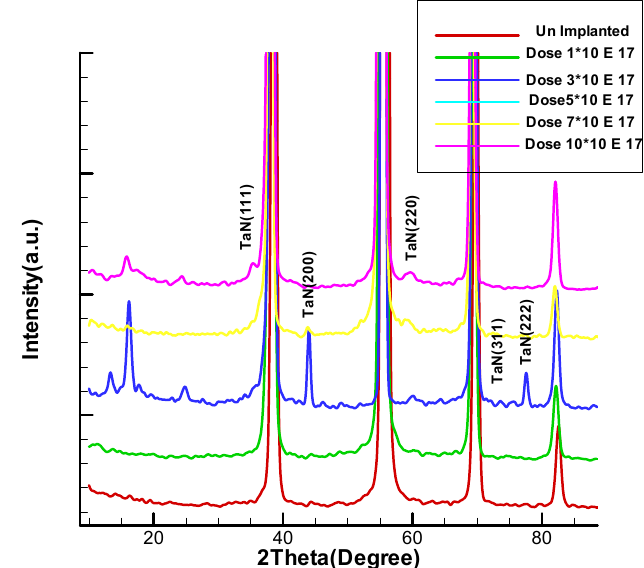
Fig. 1. XRD patterns of samples before and after ion implantation (See also Table 1).